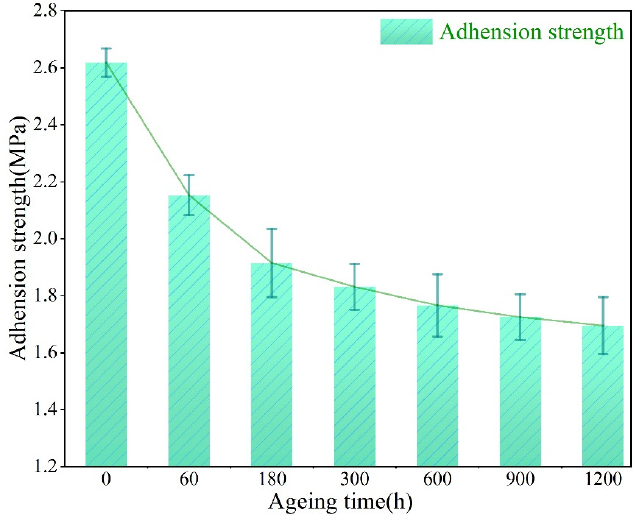
Figure 4. Relationship of adhesion between aluminum and aged epoxy coatings.